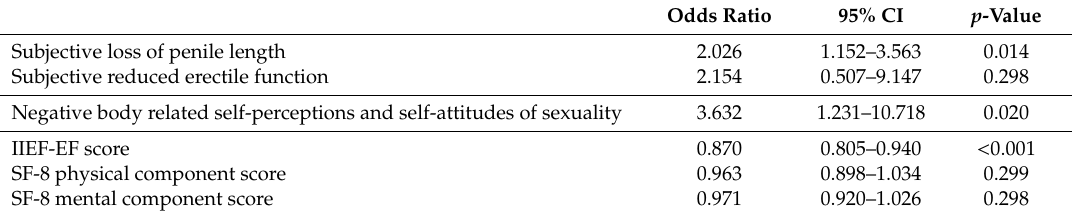
Table 3. Uni-variable logistic regression of subjective penile shortening, subjective reduced erectile function, negative body related self-perceptions and self-attitudes of sexuality, International Index of Erectile Function Erectile Function domain (IIEF-EF) and Short-Form (SF)-8 score predicting patient dissatisfaction with surgical outcome in 58 patients treated with small intestinal submucosa grafting for Peyronie’s